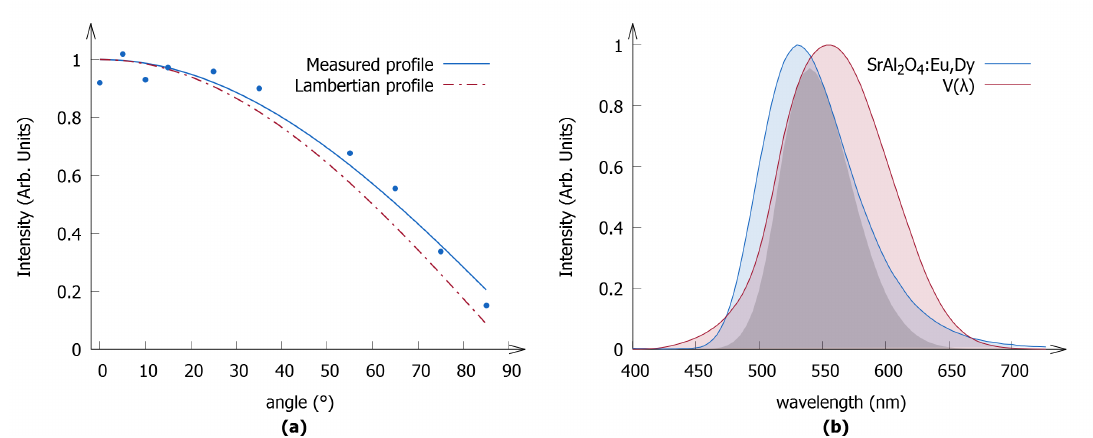
Figure 2. ( a ) Angular distribution of the emission of the polymer layers; the Lambertian profile is added as a reference; ( b ) The emission spectrum (photon flux) of SrAl 2 O 4 :Eu,Dy is shown in blue. The spectrum was recorded at 300 K under excitation at 400 nm. The photopic eye sensitivity curve is shown in red. The product of both curves is depicted as the shaded gray